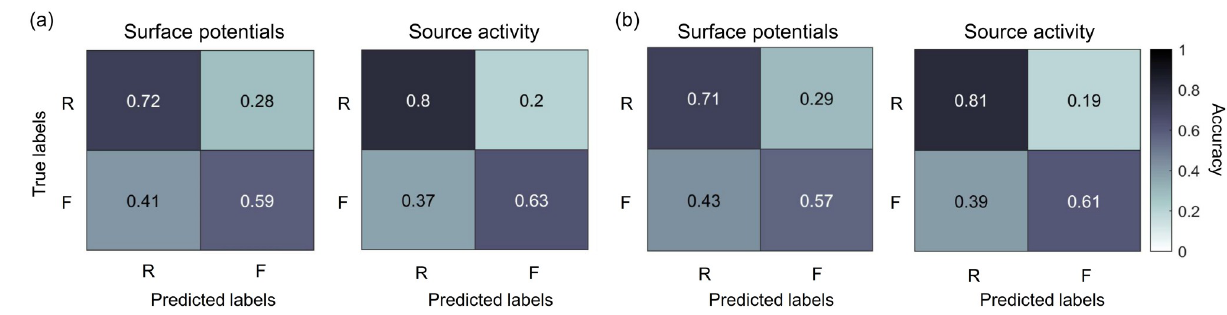
Fig 9. Normalized averaged confusion matrix for surface potentials and source activity when using CNN. (a) Confusion matrix for pre-stimulus segments and (b) on-going stimulus segments were presented. R = remembered items; F = forgotten items.